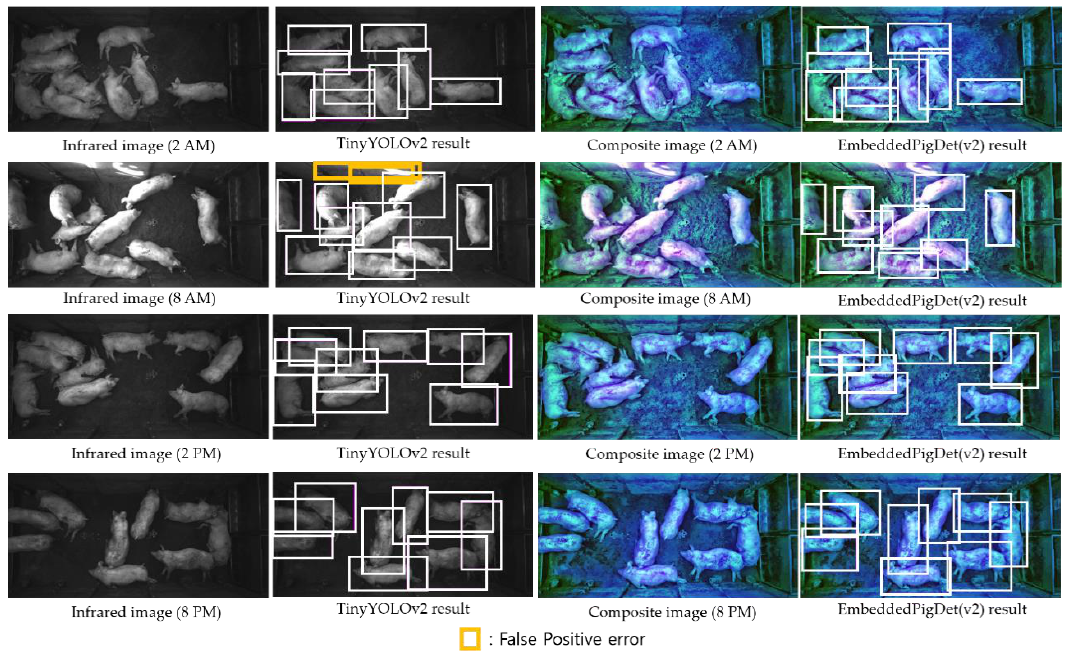
Figure 6. Detection results of TinyYOLOv2 with infrared images and EmbeddedPigDet(v2) with composite images.